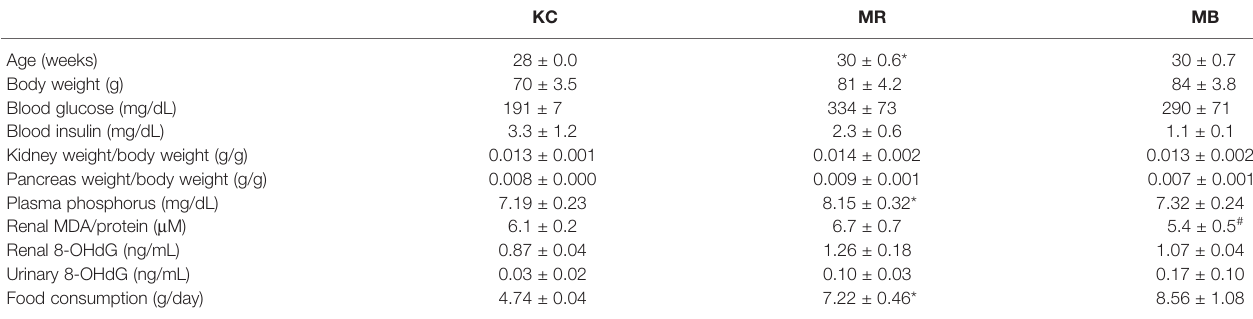
TABLE 1 | Metabolic variables of KSOM control mice and MEM mice after 10 weeks of control or barley diet